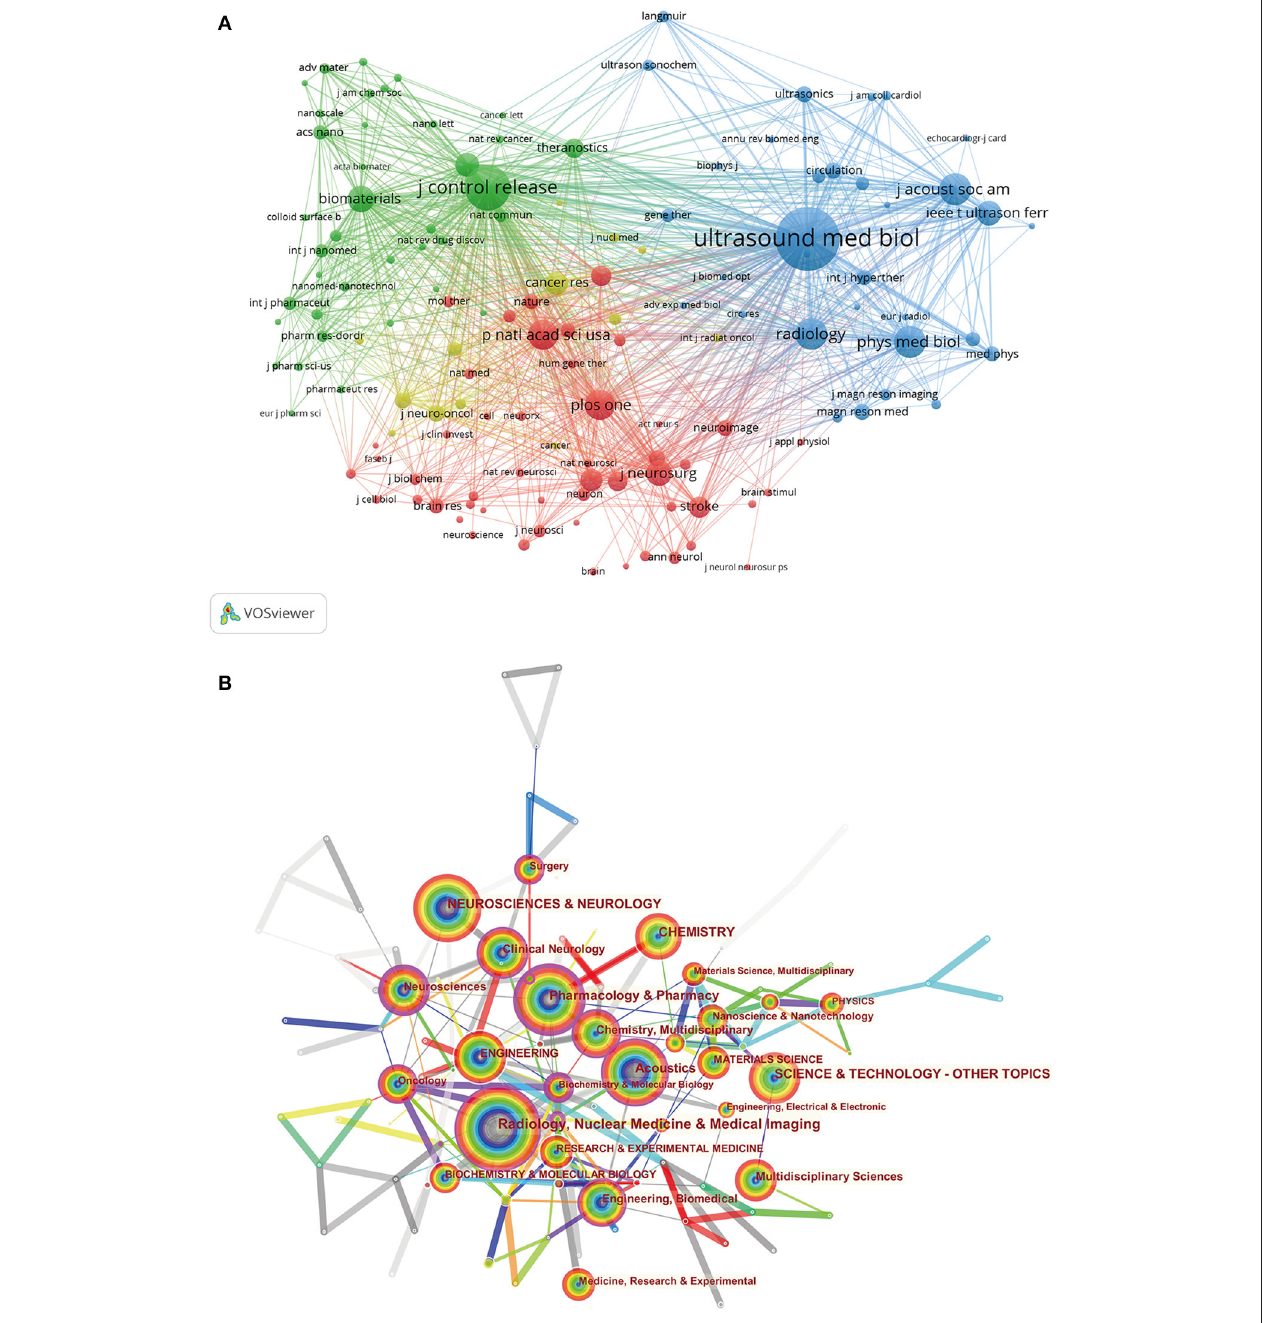
FIGURE 3 | (A) The network visualization map of journal co-citation analysis by VOS viewer. (B) The co-occurrence network of subject categories was created with CiteSpace